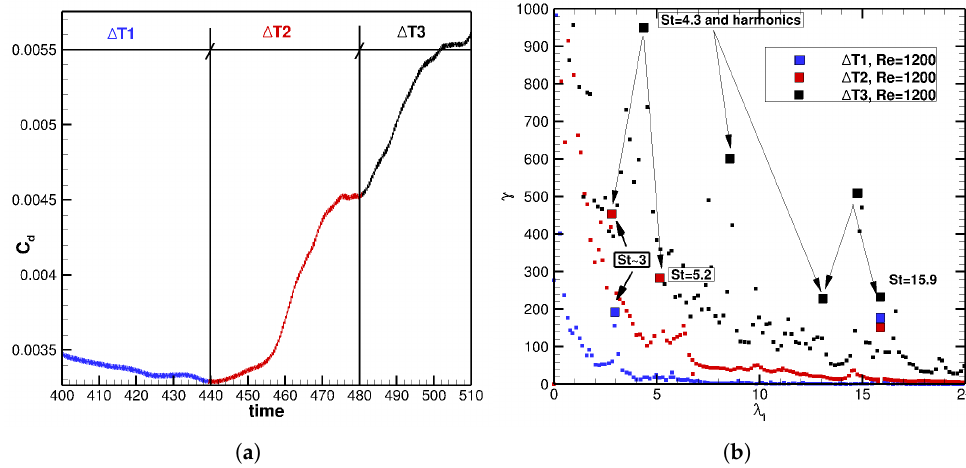
Figure 8. Wavy wall flow at Re = 1200. ( a ): drag evolution (Equation (1)) before reaching statistical convergence, considering three successive temporal ranges. ( b ): associated DMD spectra.